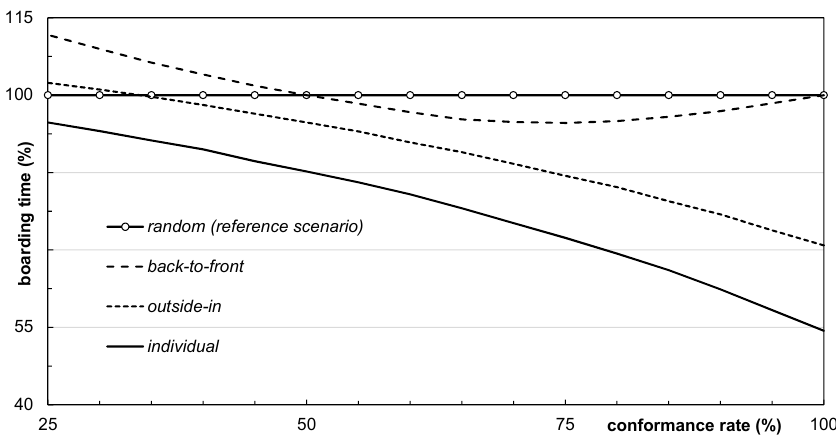
Figure 11. Boarding time of different boarding strategies with increasing conformance rate.